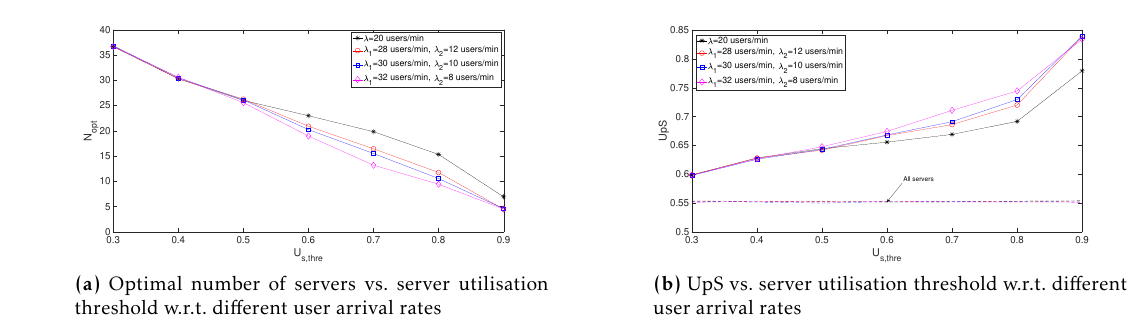
Figure 7. Impacts of server utilisation